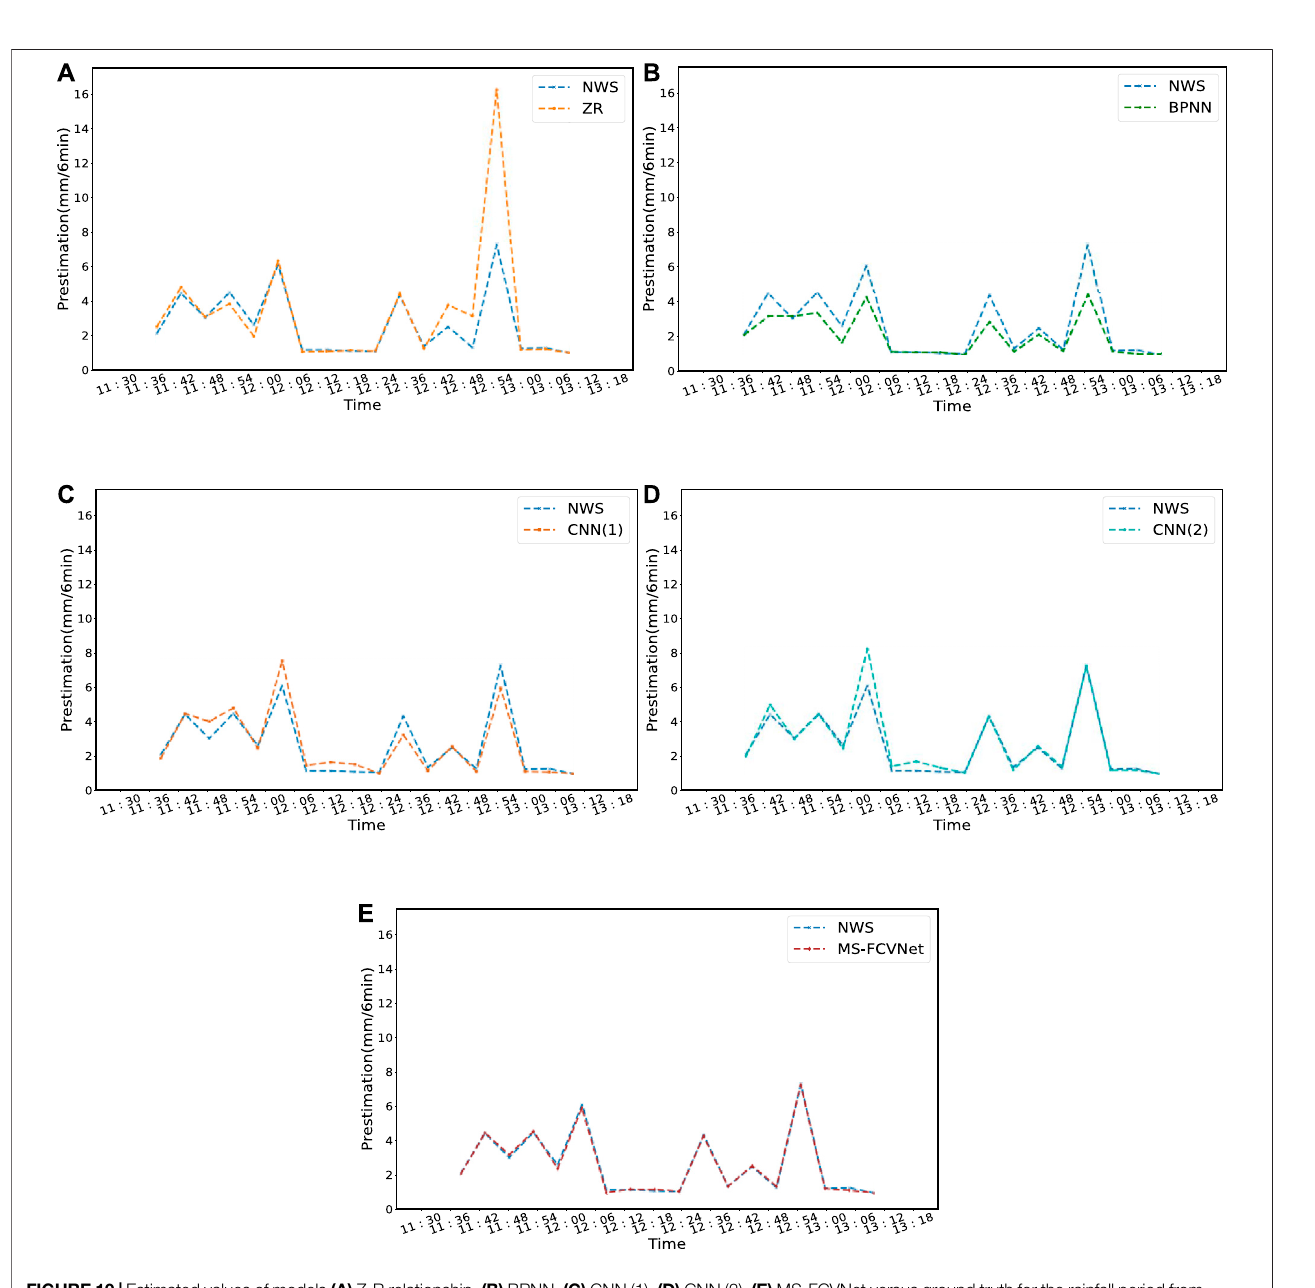
Frontiers in Earth Science |